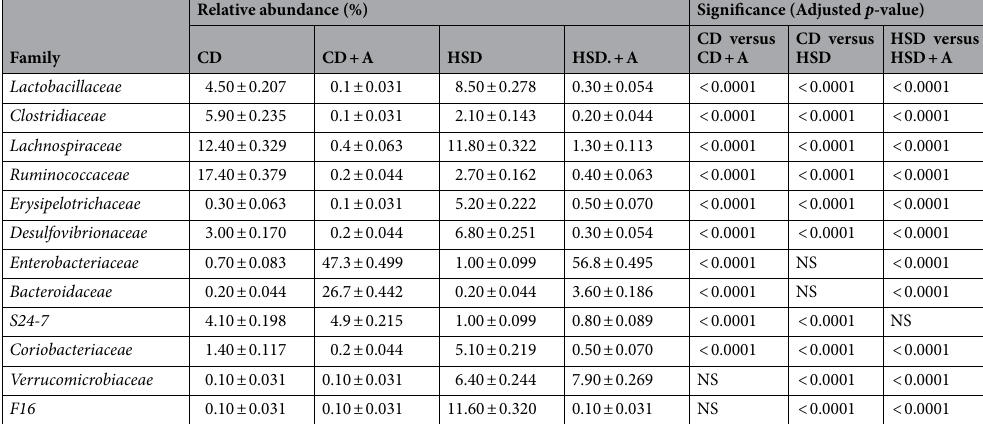
physiology of metabolic syndrome 7,31–34 . Amoxicillin treatment in HSD-fed mice substantially reduced the F/B ratio with a significant increase in the abundance of Proteobacteria. To our knowledge, this is the first study to